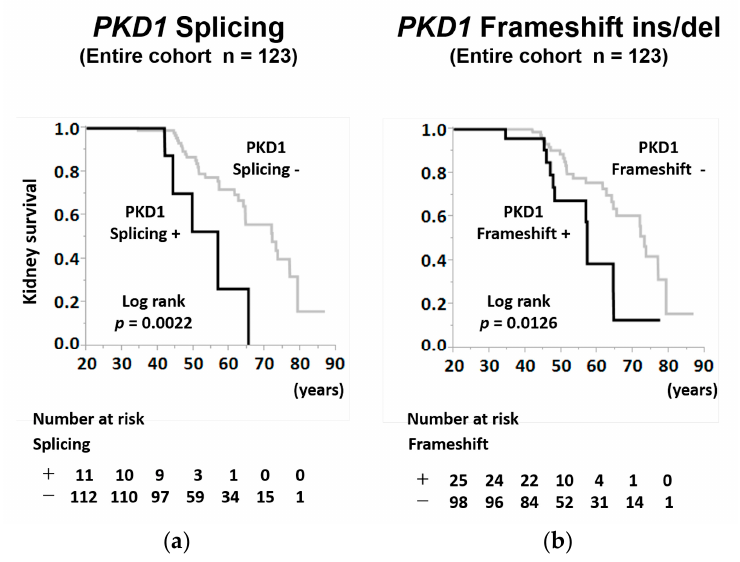
Figure 3. Kidney survival rate of patients with ADPKD stratified by PKD1 splicing mutation and PKD1 frameshift mutation in the entire cohort. ( a ) The kidney survival rates of ADPKD patients with PKD1 splicing mutation or without PKD1 splicing mutation in the entire cohort (log-rank, p = 0.0022). ( b ) The kidney survival rates of ADPKD patients with PKD1 frameshift mutation or without PKD1 frameshift mutation in the entire cohort (log-rank, p = 0.0126). The number of patients at risk for progression to RRT at each time point is mentioned below the figures. ins / del = insertion / deletion.